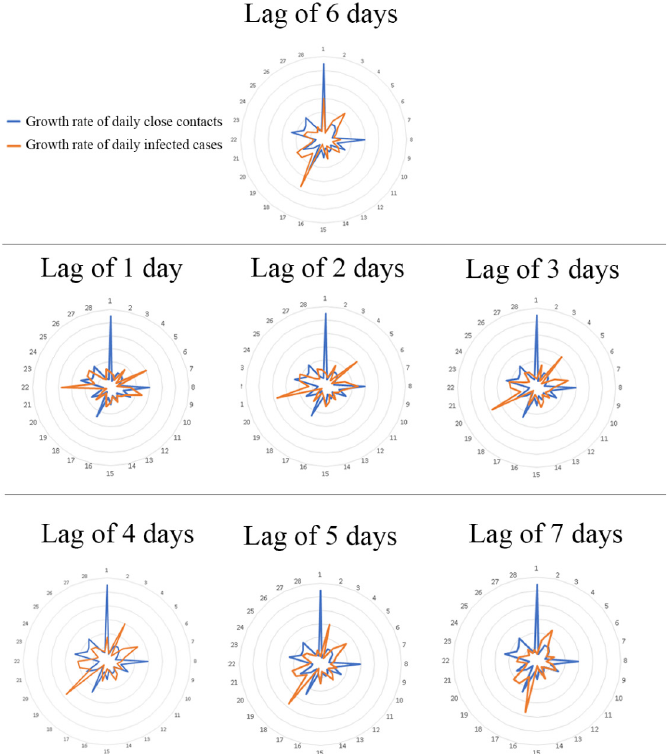
Figure 5. Radar chart of the growth rate of daily close contacts (before lockdown) and infected cases by different lag times. (Note: Each number in the figure corresponds to a single date. For example, in the radar figure for a lag of 6 days, number 1 indicates 2/14 for the growth rate of daily close contacts, whereas it also means 2/20 (lag of 6 days) for the growth rate of infected cases.)